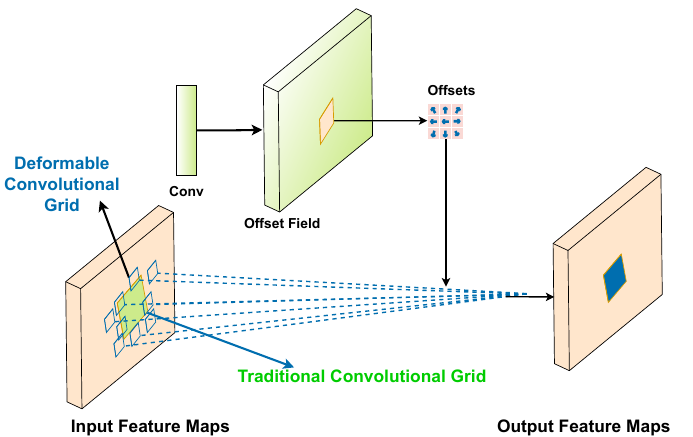
Figure 5. This figure illustrates a visual demonstration of a deformable convolution. The green grid depicts the conventional 3 × 3 convolutional operation, whereas the blue boxes highlight the effective receptive field of a similar 3 × 3 deformable